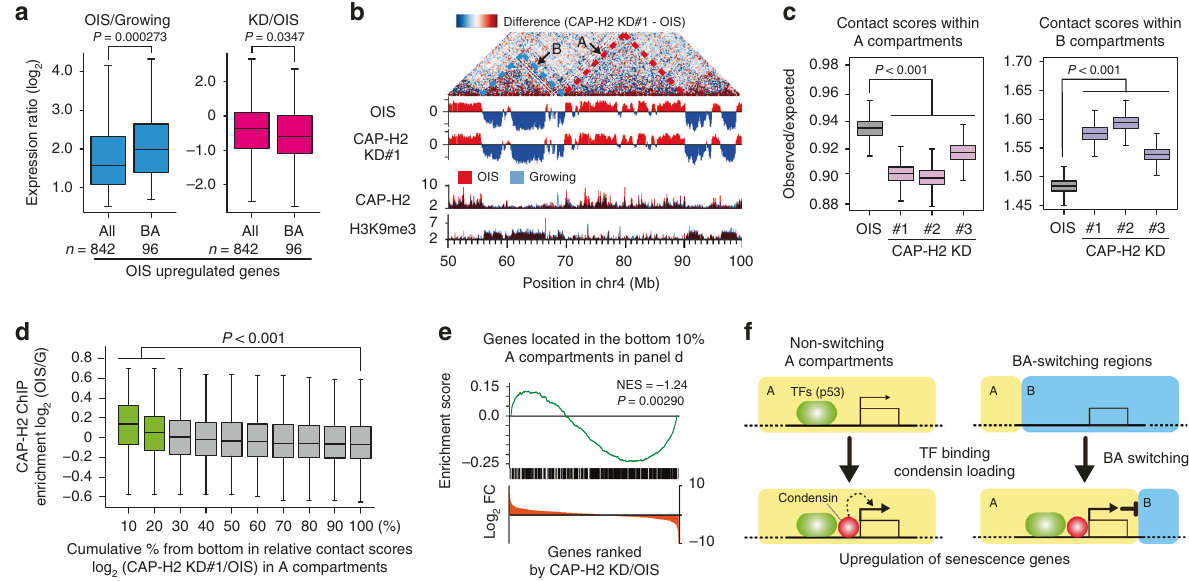
Fig. 10 Condensin reinforces euchromatic A compartments. a Left: Expression ratios between OIS and growing cells for all genes that were signi fi cantly upregulated genes ( n = 842) upon OIS, and for signi fi cantly upregulated genes present at BA-switching regions ( n = 96) shown as boxplots (central bar represents the median with boxes indicating the upper and lower quartiles, and whiskers extend to the data points, which are no more than 1.5× the interquartile range from the box). P -values were calculated by a two-sided Mann – Whitney U test. Right: The same sets of genes were used to calculate expression ratios between CAP-H2 KD and OIS control cells. b An example showing that contact scores in the A compartment were slightly reduced in CAP-H2 KD cells compared to OIS cells (red dotted line). Blue dotted line indicates that contact scores in the B compartment were relatively elevated by CAP-H2 KD. Difference map between OIS and CAP-H2 KD cells shows a 50 Mb genomic region in chromosome 4. PCA scores and ChIP-seq data (CAP- H2 and H3K9me3) are shown beneath. c Effect of CAP-H2 KD on contact scores within A and B compartments. Distance-normalized contact scores at 200 kb resolution were calculated by observed contact scores divided by expected scores estimated from all combinations separated by same distances. Boxplots are shown as in panel a , and P -values were calculated by a two-sided Mann – Whitney U test. d CAP-H2 relative enrichment (in OIS over growing cells) in A compartments ranked by relative contact scores between CAP-H2 KD and OIS cells. Distance-normalized contact scores were used for this analysis. Boxplots are shown as in panel a , and P -values were calculated by a two-sided Mann – Whitney U test. e GSEA of genes ( n = 710) located in the bottom 10% of A compartments with the lowest relative contact scores between CAP-H2 KD and OIS cells (data shown in panel d ) and with elevated CAP-H2 enrichment in OIS cells compared to growing cells. Human genes were ranked by expression fold changes (FC), where expression levels of genes in CAP-H2 KD cells were divided by those in OIS cells. f A model to explain how condensin may reinforce non-switching A compartments (left) and promote/maintain BA compartmental transitions during senescent processes (right; see Discussion for